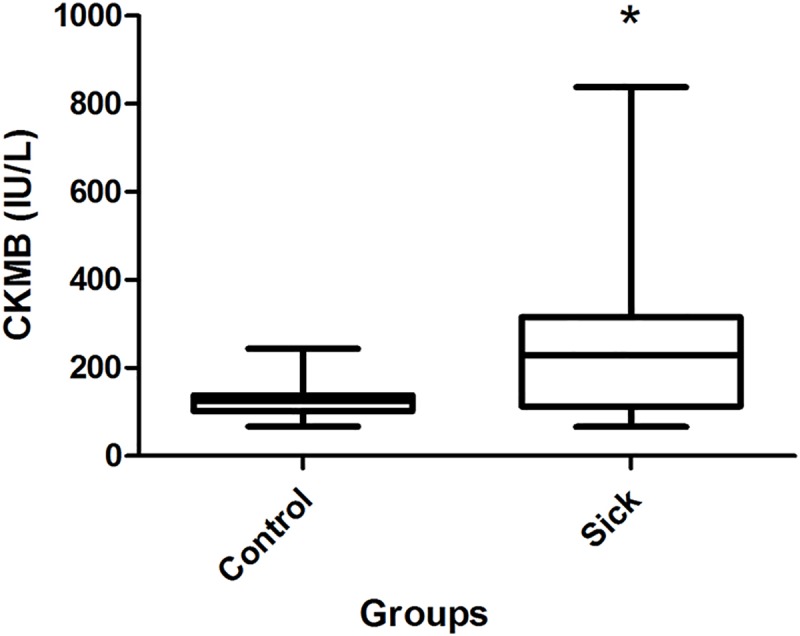
Sample distribution of CK-MB (UI/L) concentrations between the groups with the results of the statistical test.